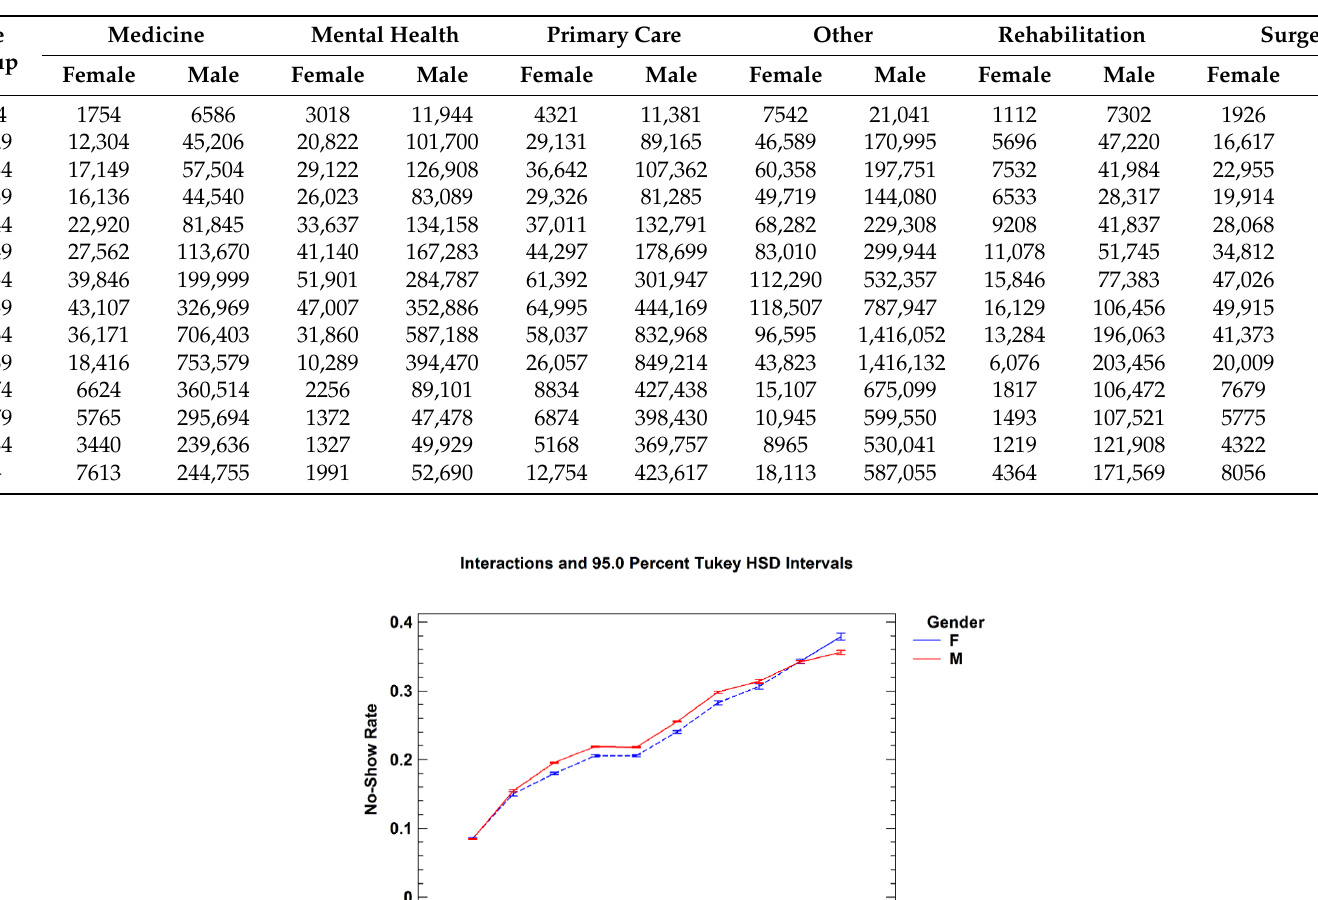
Table 3. Appointment frequencies for all service lines.